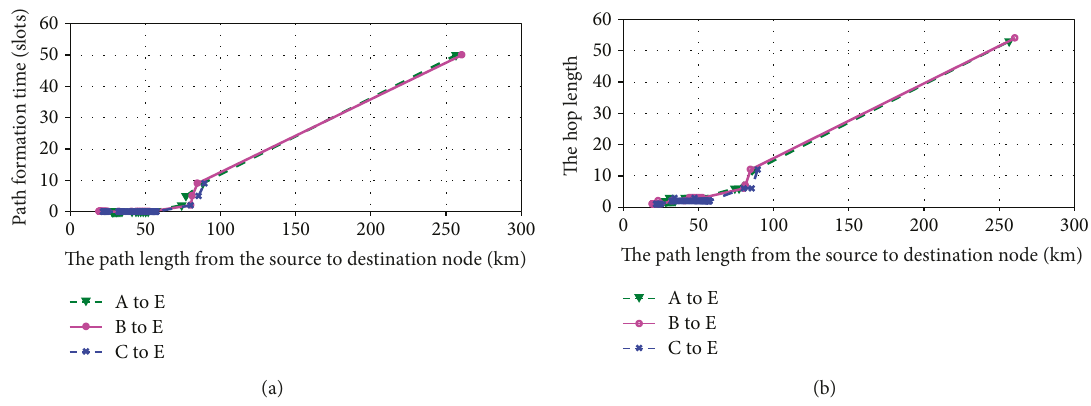
Figure 9: (a) The relationship between path formation time and path length. (b) The relationship between hop length and path length for di ff erent source-destination in the 1st orbit hyperperiod.